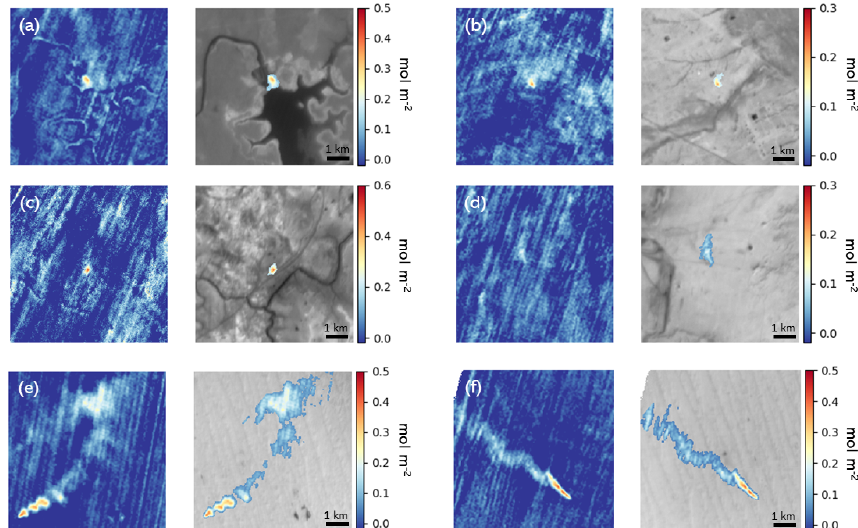
Figure 5. Retrieved methane enhancement fields. In the left plot of each plot pair, the methane enhancement above the local background value is shown in a 7 × 7km 2 region of interest centered on the plume. In the right plot of each plot pair, the extracted plume is overlaid on top of the retrieved surface reflectance. The methane enhancement colour scale is in units of molm − 2 . Description, location, and date of observations: (a) hydroelectric reservoir at the Lom Pangar dam, Cameroon, 20 April 2017; (b) suspected liquid unloading event in the Permian basin, Texas, USA, 17 October 2018; (c) underground coal mine vent near Camden, Australia, 18 October 2018; (d) underground coal mine vent near Farmington, New Mexico, USA, 18 September 2018; (e) natural gas compressor facility near Korpezhe, Turkmenistan, 24 February 2019; (f) same natural gas compressor facility near Korpezhe, Turkmenistan, 9 March 2019. In all retrieval fields, the plume enhancement competes against retrieval artefacts that are usually oriented along the direction of the satellite orbital